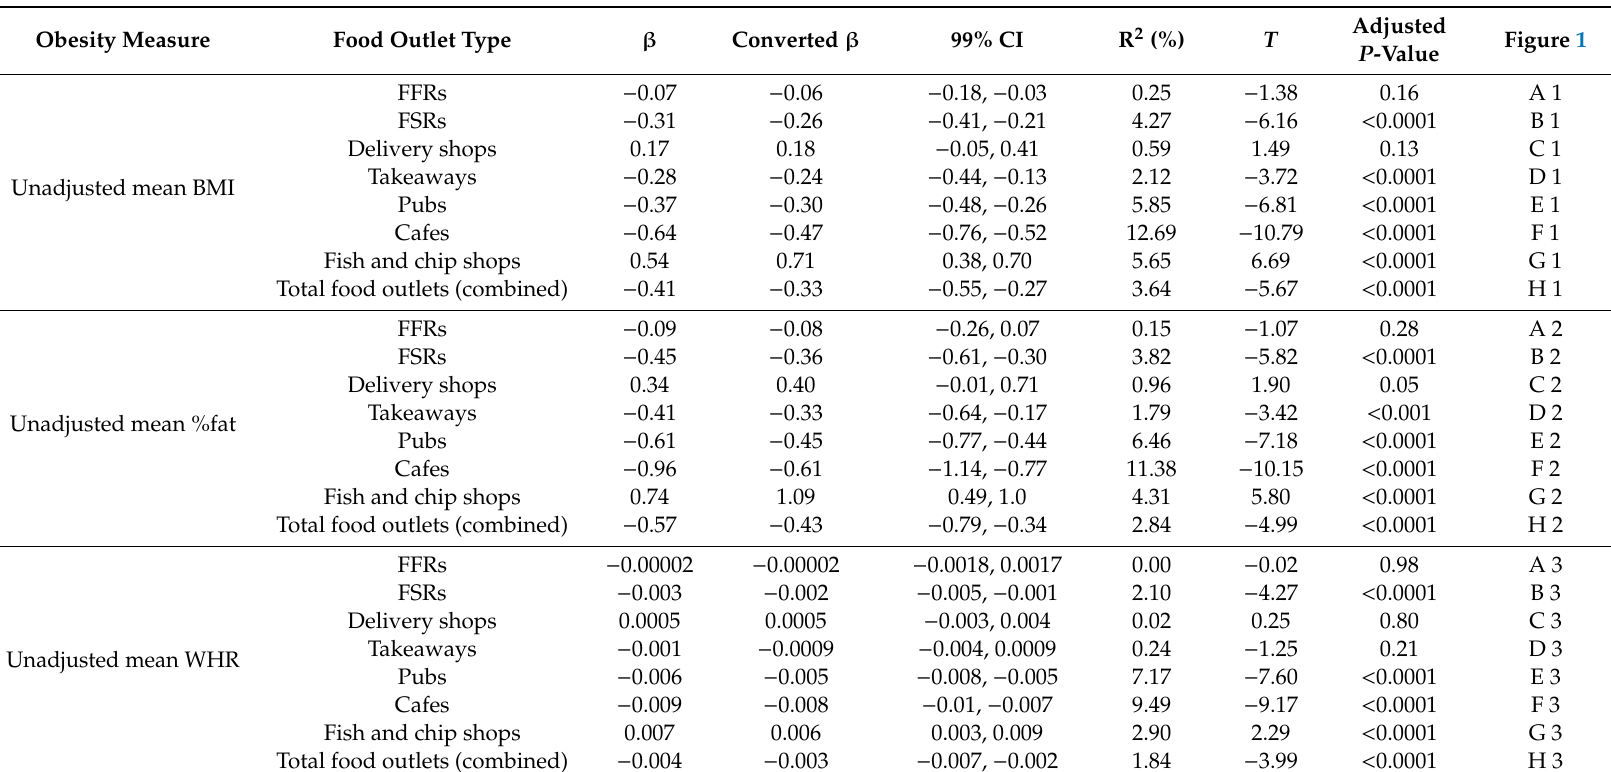
Adjusted Figure 1 P -Value